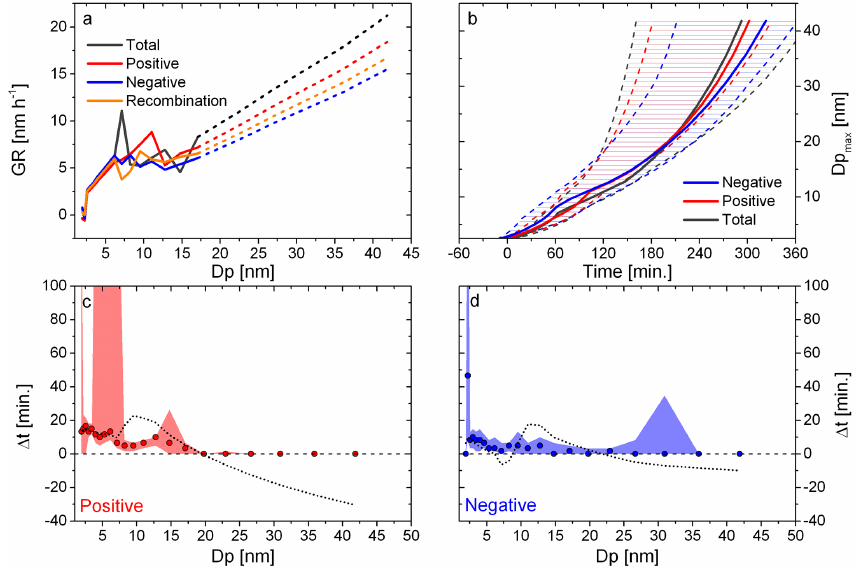
Figure 8. Same as Fig. 7 but for four NPF events with 1t <20min.